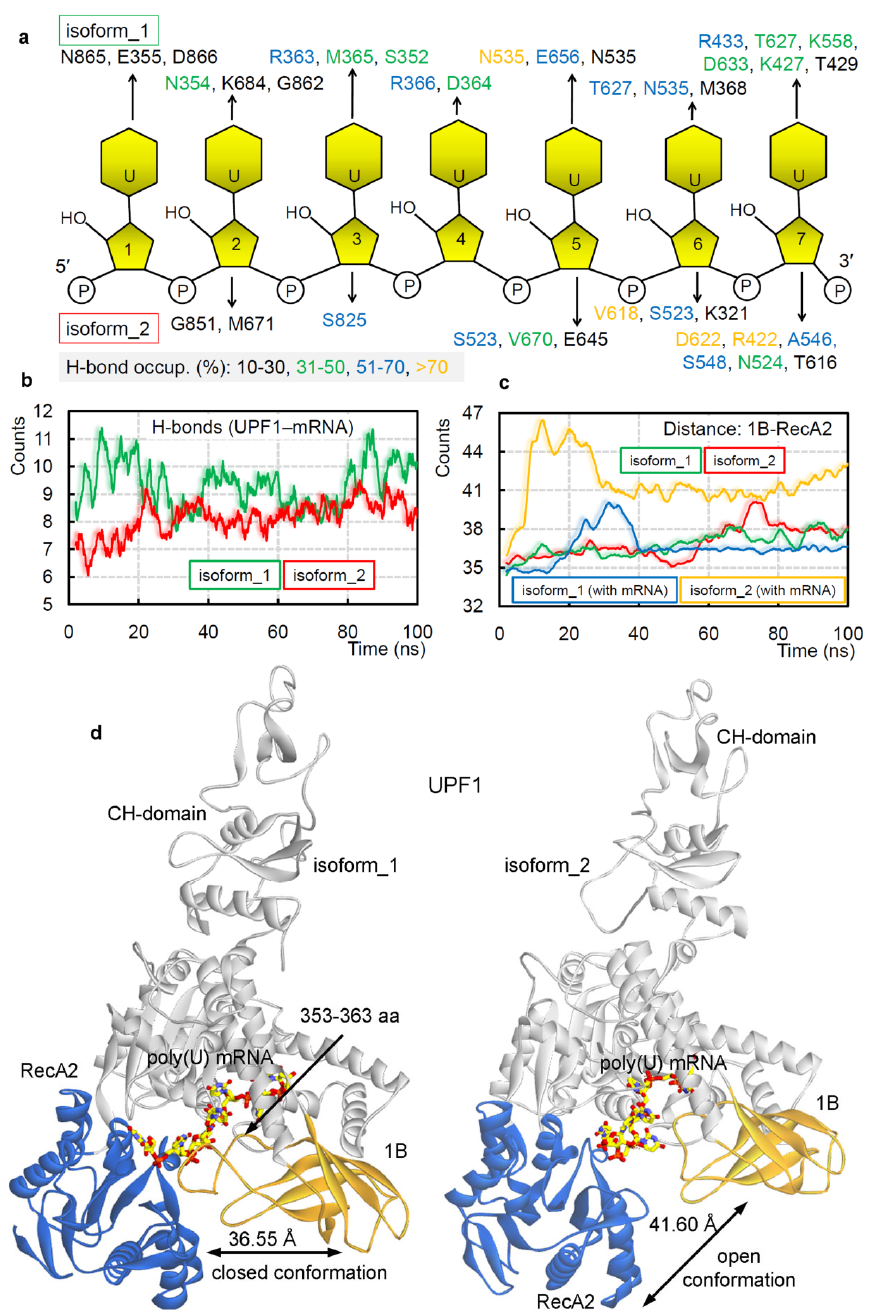
Figure 2. Diversity in the binding of UPF1 isoforms with poly(U) mRNA, reflected in their structural dynamics. ( a ) Individual UPF1 amino acids making long-lasting interactions with the nucleotides having occupancy ≥ 10%/ns. ( b ) Intermolecular hydrogen bond interactions between UPF1 isoform_1 or isoform_2 with the poly(U) mRNA motifs. ( c ) The distance center of mass between 1B and RecA2 domains from both isoforms in the presence/absence of the poly(U) mRNA. ( d ) The structural dynamics of the ‘regulatory loop’ in presence (isoform_1) and absence of (isoform_2) of the 11 aa insertion (353 ‐ GNEDLVIIWLR ‐ 363). The averaged UPF1 ‐ mRNA coordinates extracted from 100 ns (nanosecond) MD (molecular dynamics) simulations, with labeled average distance marked based on data from panel ( c ).